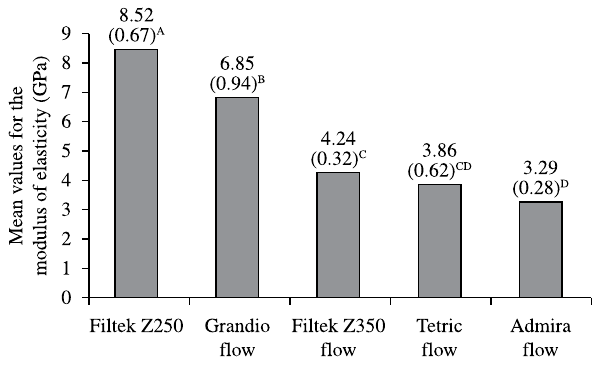
Figure 3. Mean values of ME (GPa) and standard deviations ( ) of the materials studied. Different superscript letters indicates that the materials are statistically different at 5% using the Tukey test.